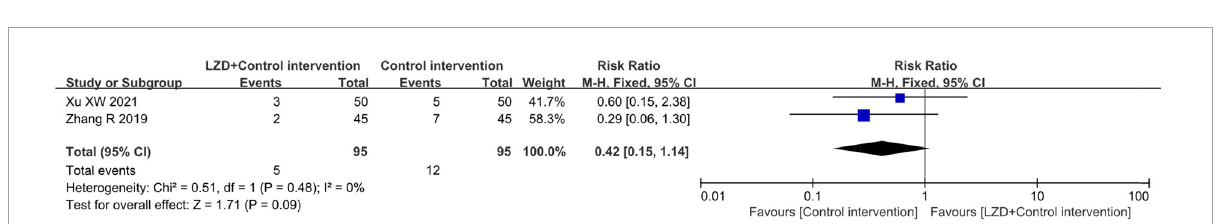
FIGURE7 Forest plot for comparison between the intervention group and control group concerning adverse events (hypotension, nausea, bradycardia, vertigo, and fatigue) after treatment in two included